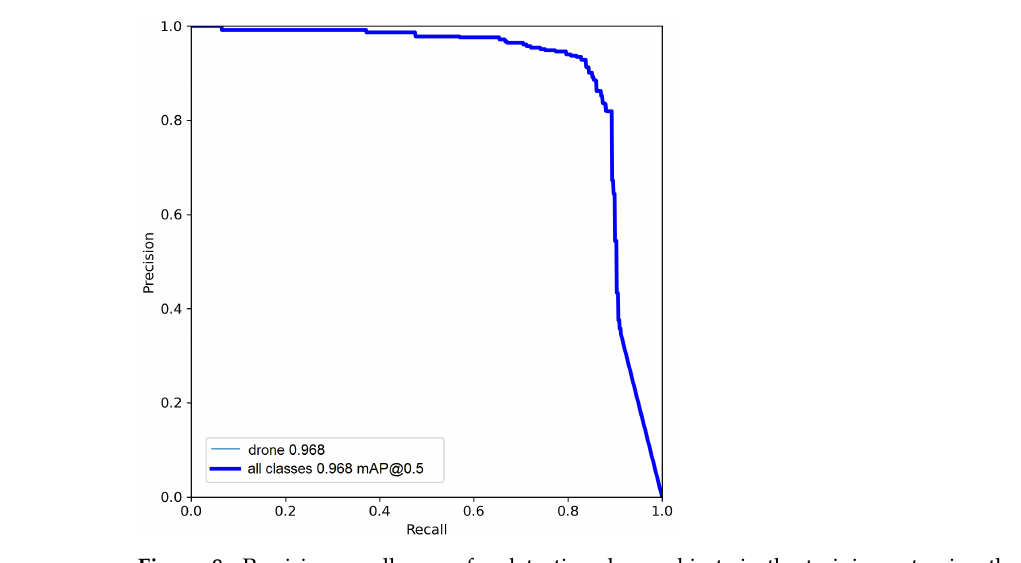
Figure 8. Precision–recall curve for detecting drone objects in the training set using the proposed fine-tuned model.